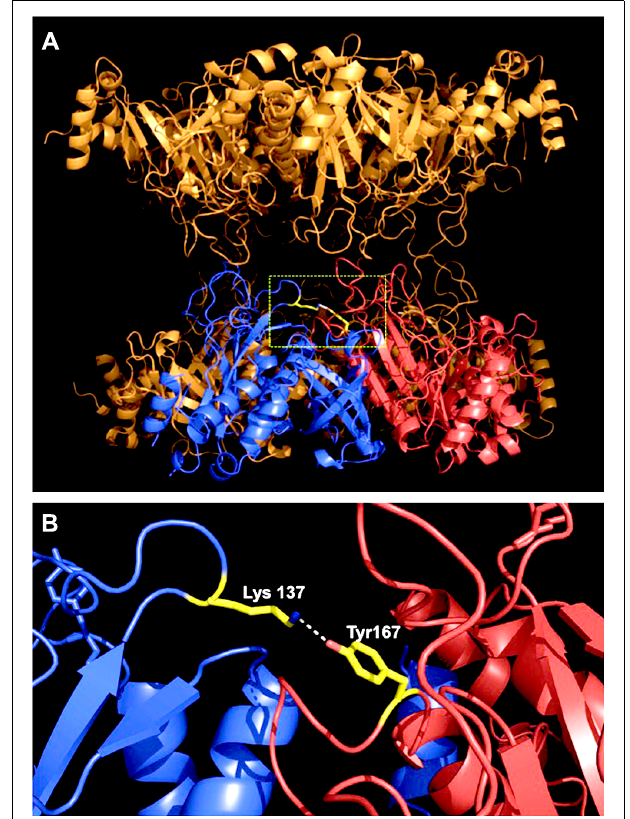
FIGURE 1 | Location of the regulatory nitration site within the three-dimensional structure of MtGS1a. (A) Side-view of the MtGS1a molecule, which is a decamer composed of two stacked (face-to-face) pentameric rings, with 10 active sites formed between the C-terminal domain of one subunit and the N-terminal domain of the other subunit within a pentameric ring (Seabra etal., 2009).The position ofTyr167 is shown in yellow, in a solvent-accessible loop at the interface between two neighboring subunits, which are colored blue and red. (B) Arrangement of two neighboring subunits, highlighting the position of tyrosine 167 of the subunit labeled in red, close to the enzyme active site, and establishing an hydrogen bound with Lys-137 of the neighboring subunit, which is presented in